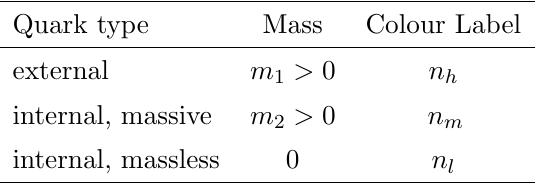
Table 1. Conventions adopted in this work for closed quark